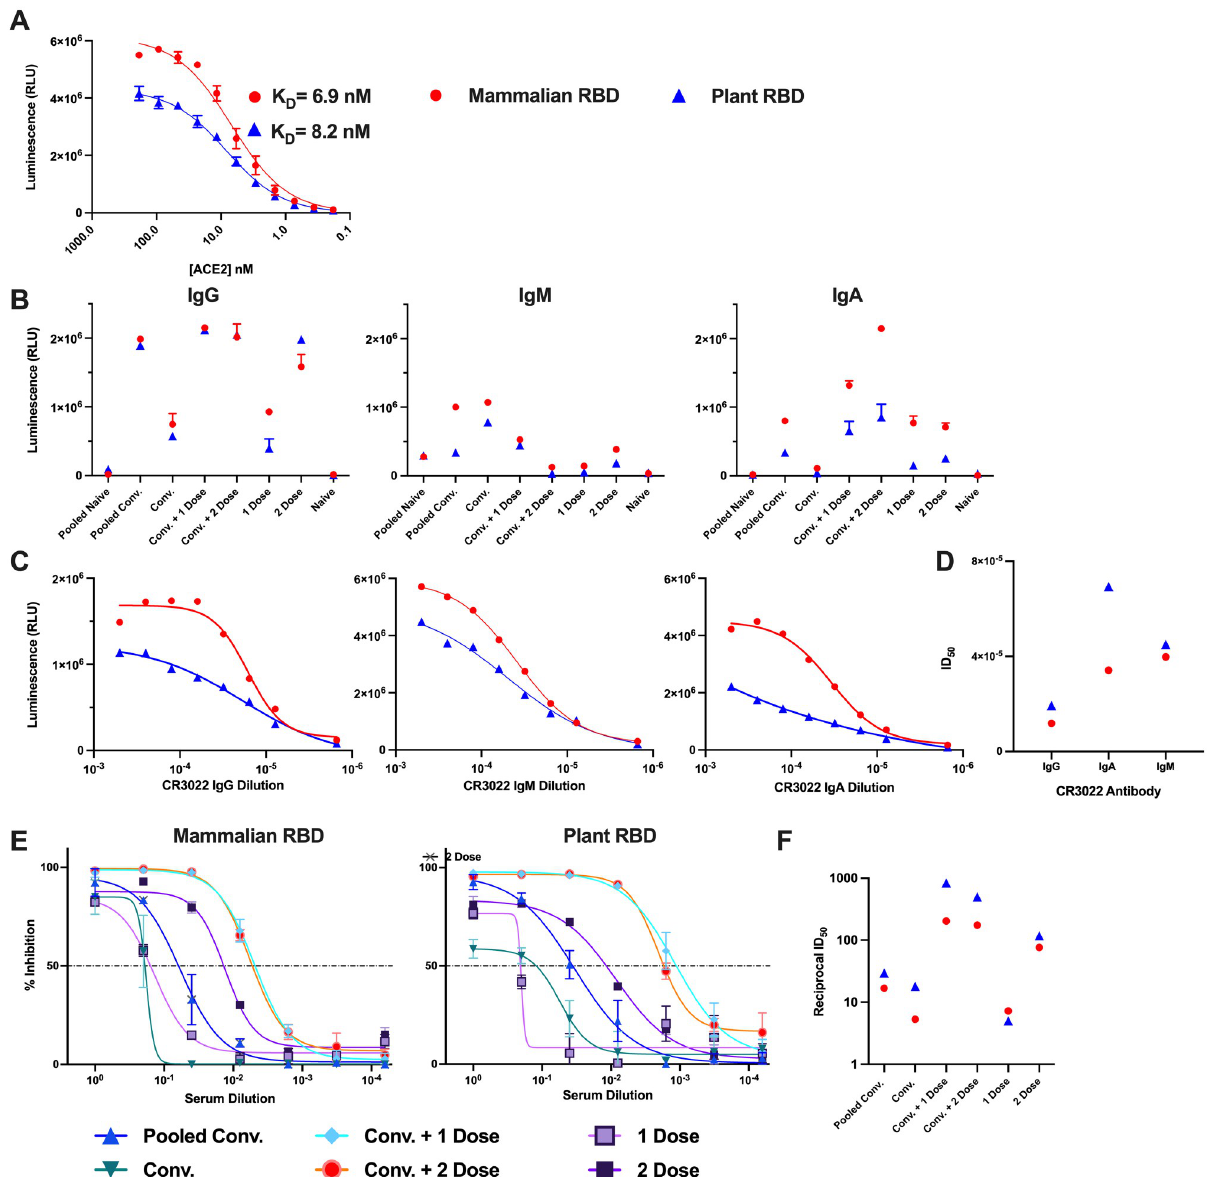
Fig 4. Evaluation of plant-expressed RBD protein functionality, folding and binding kinetics. A comprehensive assessment of protein function of the RBD produced in N . benthamiana as it pertains to protein folding and binding to ACE2 receptor, recognition and neutralization by antibodies in sera from SARS-CoV-2 exposed individuals. (A) Indirect ELISA demonstrating binding kinetics of soluble human ACE2 to immobilized mammalian RBD (red circle) and plant RBD (blue triangle). (B) Binding and recognition of immobilized mammalian and plant produced RBD by IgG, IgM and IgA polyclonal antibodies in sera of pooled na ï ve (unvaccinated, uninfected individuals; n > 100), pooled convalescent (pooled Conv.) (n > 100), convalescent and vaccinated with one dose (Conv. + 1 dose), convalescent and vaccinated with two doses (Conv. + 2 dose), vaccinated with one dose (1 dose), vaccinated with 2 doses (2 doses) of Pfizer (BNT162b2) and na ï ve (PCR negative confirmed). Pooled sera are samples pooled from a surveillance study of 100 individuals with (pooled convalescent) or without (pooled na ï ve) prior SARS-CoV-2 infection. While the rest of the samples were collected from single individuals from each category described above. (C) Binding and recognition of immobilized mammalian and plant produced RBD by conformation dependant monoclonal IgG, IgM, and IgA CR3022 antibodies and (D) their half-maximal inhibitory dilution (ID 50 ) values. (E) Relative inhibition percentage of anti-SARS-CoV-2 neutralizing antibodies in blocking immobilized mammalian and plant produced RBD from binding to soluble ACE2 by snELISA. This assay is representative of technical triplicates or quadruplicates and presented as mean ± standard deviation. (F) Reciprocal ID 50 values from (E) for mammalian- and plant-expressed